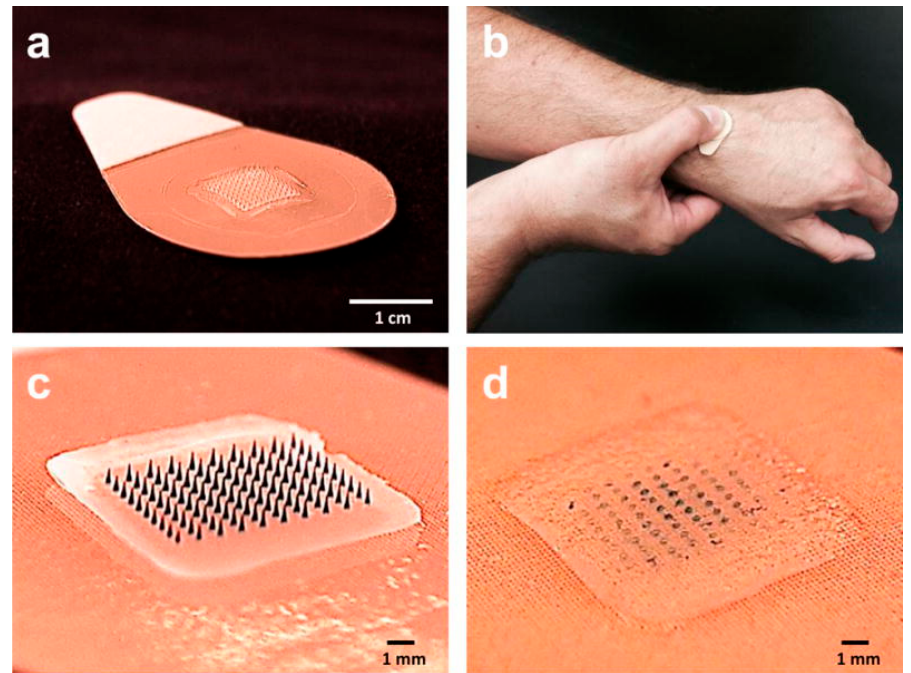
Figure 4. Microneedle patch (MNP) for influenza vaccination. ( a ) The MNP contains an array of 100 microneedles measuring 650 µm tall that is mounted on an adhesive backing. ( b ) The MNP is manually administered to the wrist, enabling self-administration by study subjects. ( c ) Microneedles encapsulate influenza vaccine (represented here by blue dye) within a water-soluble matrix. ( d ) After application to the skin, the microneedles dissolve, thereby depositing vaccine in the skin and leaving behind a patch backing that can be discarded as non-sharps waste. (Reprinted with permission from Ref. [81]).